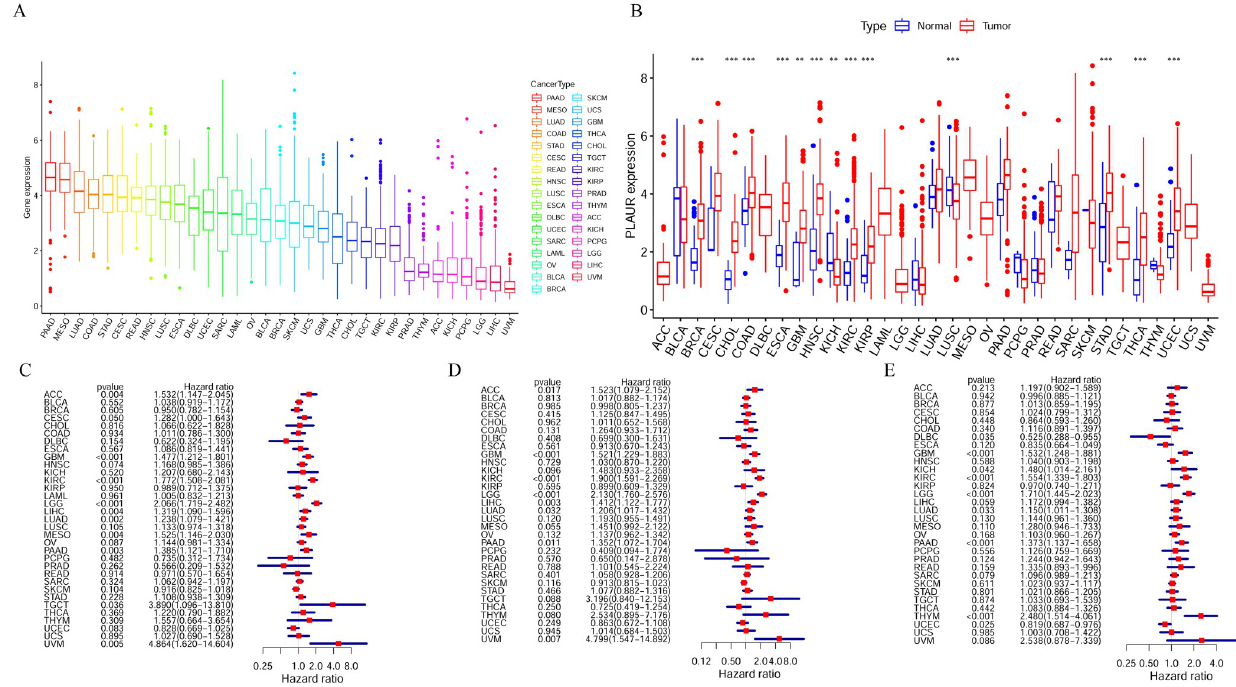
Fig 1. Pan-cancer expression analysis of PLAUR in 33 tumors. A. Ranking of PLAUR expression mean values in 33 tumors; B. Analysis of PLAUR expression in 33 tumors ( �� P < 0.01, ��� P < 0.001); C. Analysis of overall survival (OS) of PLAUR in 33 tumors; D, Analysis of disease-specific survival (DSS) of PLAUR in 33 tumors; E, Analysis of PLAUR in progression-free interval (PFI) analysis in 33 tumors.